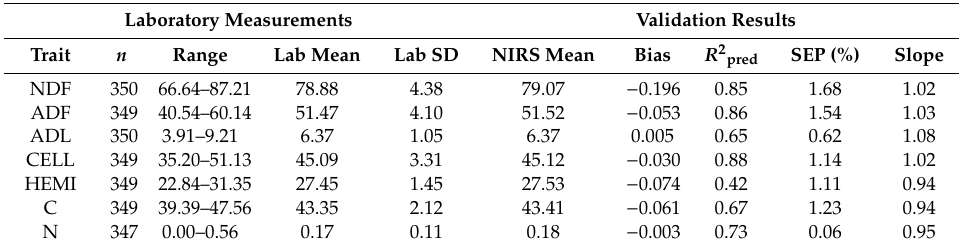
Table 2. Near-infraredspectroscopy(NIRS)validationstatisticsdisplayinglaboratoryreferencemeasurements vs. NIRS predicted results for the broad models and validation